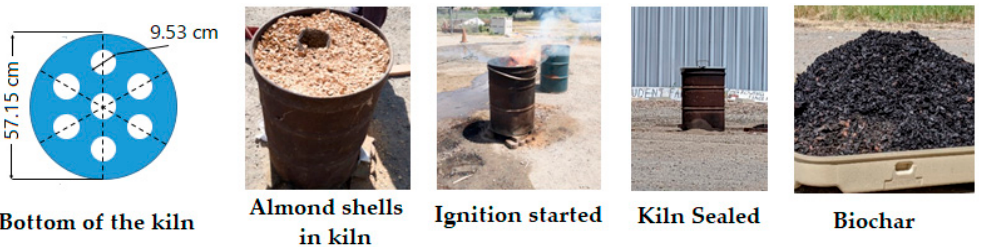
Figure 2. Production of biochar in fixed-bed pilot-scale kiln.